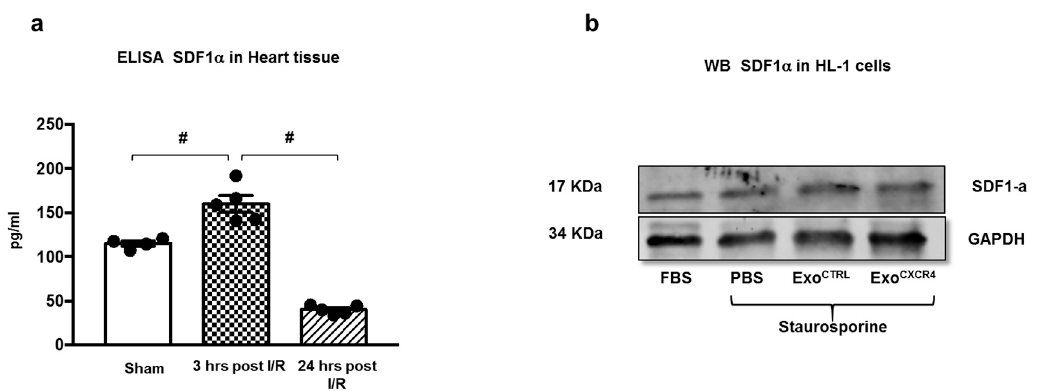
Figure A2. ( a ) Levels of SDF-1 α detected by ELISA in rat heart tissue at 3 and 24 h post MI ( n = 4 rats/group for Sham; n = 5 rats/group for 3h and 24h) # p < 0.05 (one-way analyses of variance-ANOVA with post-hoc multiple comparisons using the Tukey-Kramer multiple comparisons test for paired parametric comparisons). ( b ) WB for SDF-1 α on HL-1 cell lysate following staurosporine treatment.